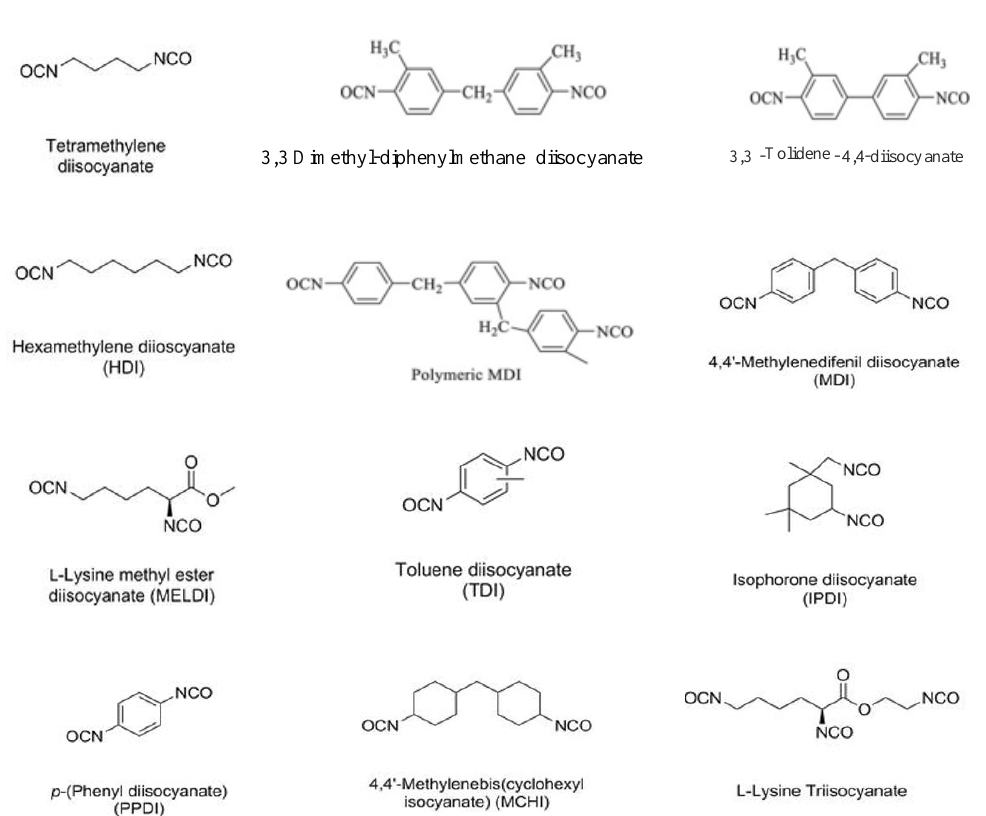
Figure 1. Diisocyanates commonly used for polyurethane synthesis (adapted with permission from [40]).